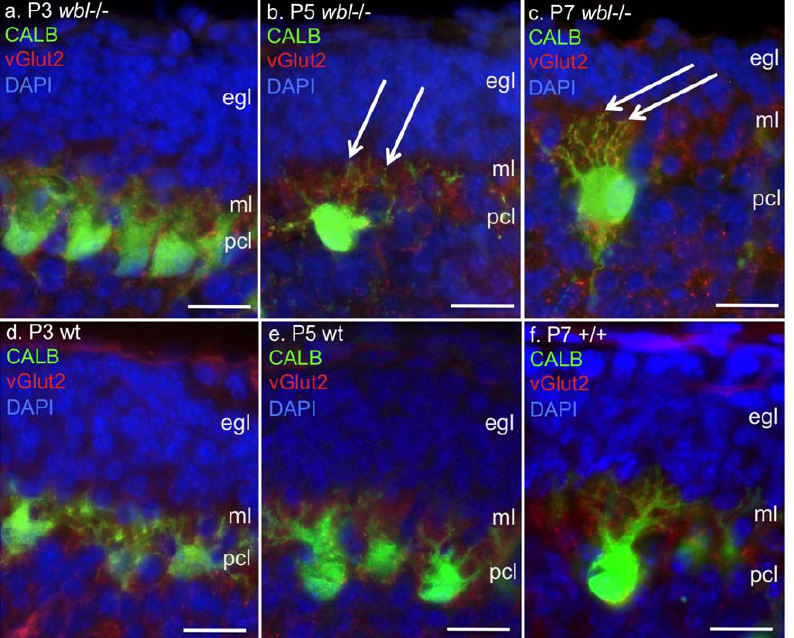
Figure 5. Purkinje cell loss coincides with the appearance of climbing fibers in the developing molecular layer. Panels d, e, f show climbing fibers labeled by anti-vGlut2 (red) and Purkinje cells labeled by anti-calbindin (green) in wild type controls at P3, P5 and P7. Climbing fibers can be seen to extend to the limit of the developing molecular layer (ml) inferior to the external granule cell layer (egl). In age-matched mutant littermates (panels a,b,c) Purkinje cells (pcl) have an unusual appearance beginning at P5, multiple thin dendrites are seen with a prominent staining rounded soma (arrow). Scale bar indicates 25 microns.